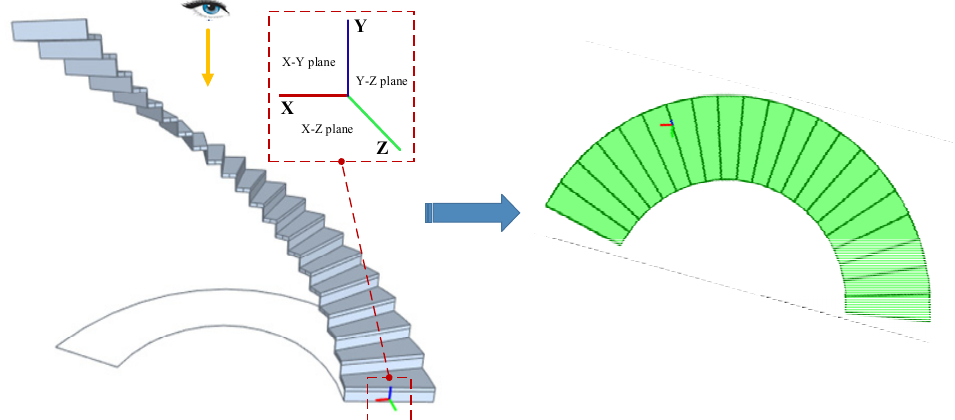
Figure 4. Illustration of the X-Z projection for a spiral stair.